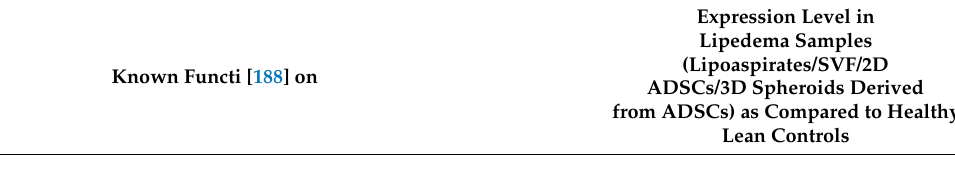
Table 2. Summary of genes and micro-RNAs screened and validated for